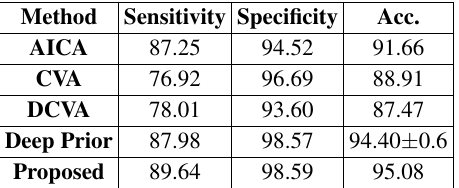
Table 2. Quantitative comparison for the Santa Barbara scene.